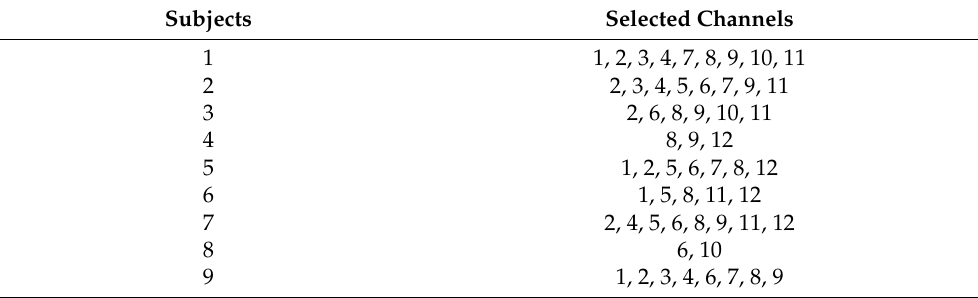
Table 1. Subject-wise channel selection using LASSO homotopy-based spare representation.